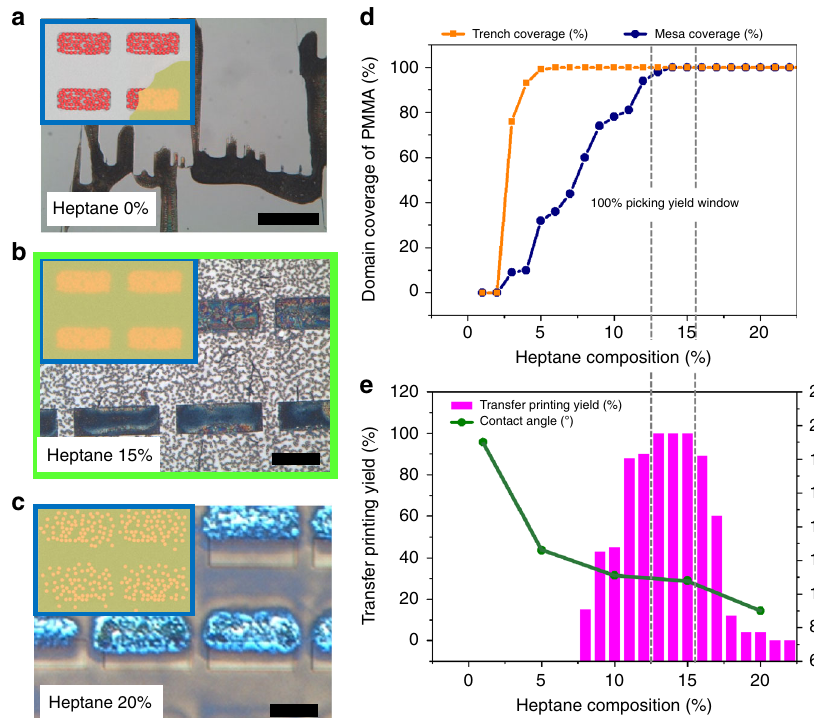
Fig. 3 Engineering binary solvent for extracting assembled QDs using a sacri fi cial transfer-medium. a – c Optical images of spun-cast PMMA fi lm on patterned QD substrate at different heptane composition are shown. Schematics of each images are shown in respective insets. Scale bar of a denotes 100 µ m. Scale bars of b , c denote 5 µ m. d Domain coverages of PMMA fi lm on trench and mesa domain, plotted separately as a function of heptane composition. e Transfer printing yield of patterned QDs and measured contact angles of spun-cast PMMA solution on PDMS surface are plotted as a function of heptane composition. The grey dotted lines across ( d ) and e indicate the optimised experimental window in which PMMA coverage reaches 100% for both trench and mesa domains and as a consequence gives 100% picking